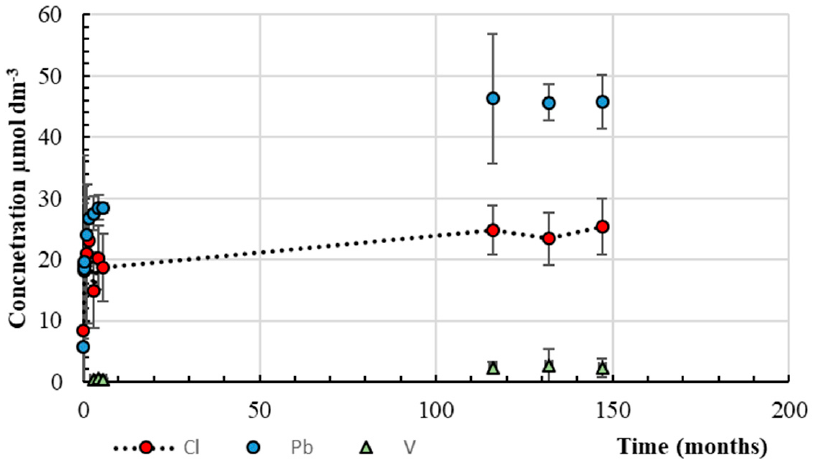
Figure A1. The evolution of Pb tot , Cl tot and V tot concentrations in the experimental solutions with time.